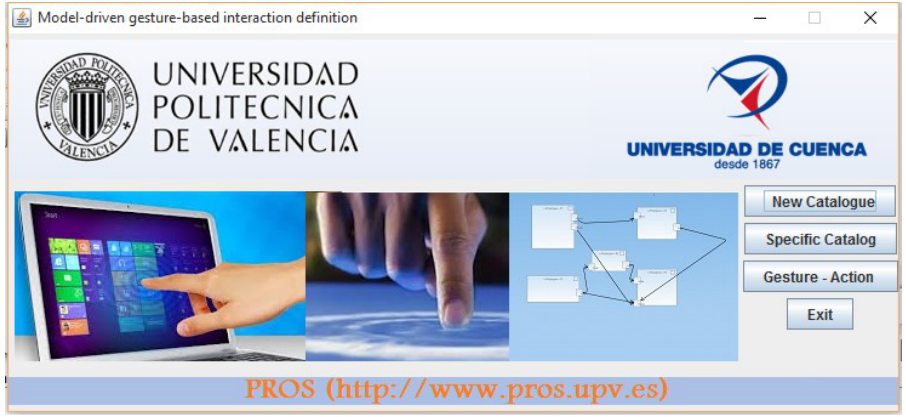
Figure 7 . Main interface of the tool